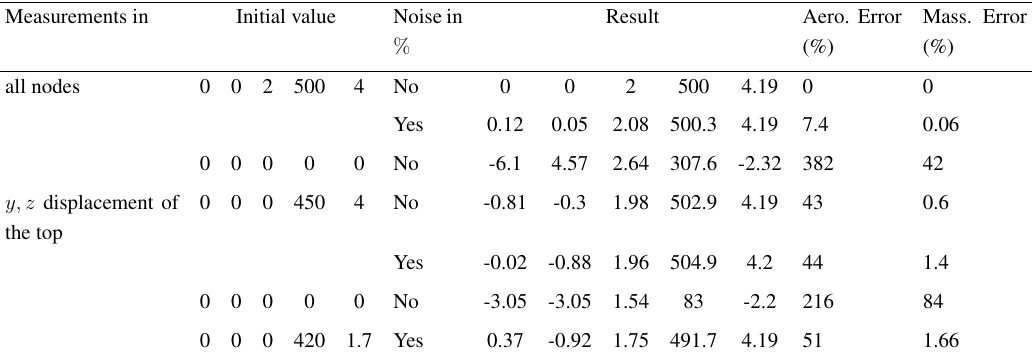
Table 1 . Test results with Tikhonov’s regularization